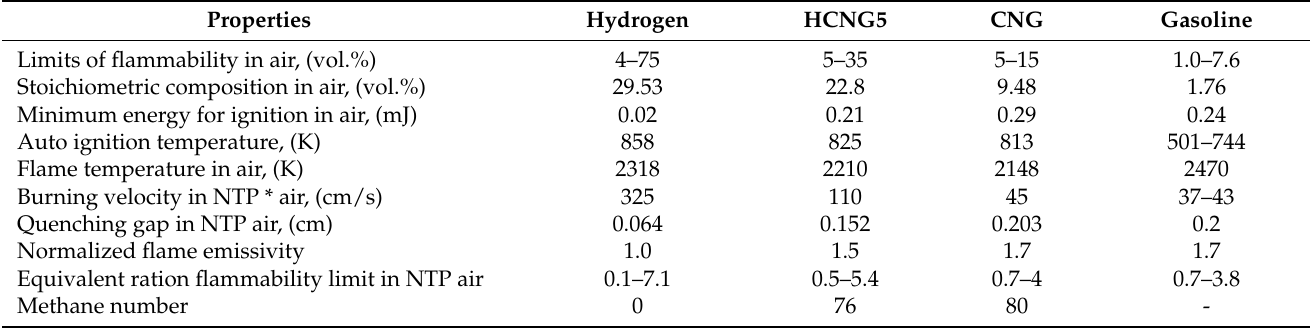
Table 1. The fuel characteristics of hydrogen, HCNG5 fuel mixture (5% hydrogen in methane), compressed natural gas (CNG) and gasoline (Reprinted from ref.